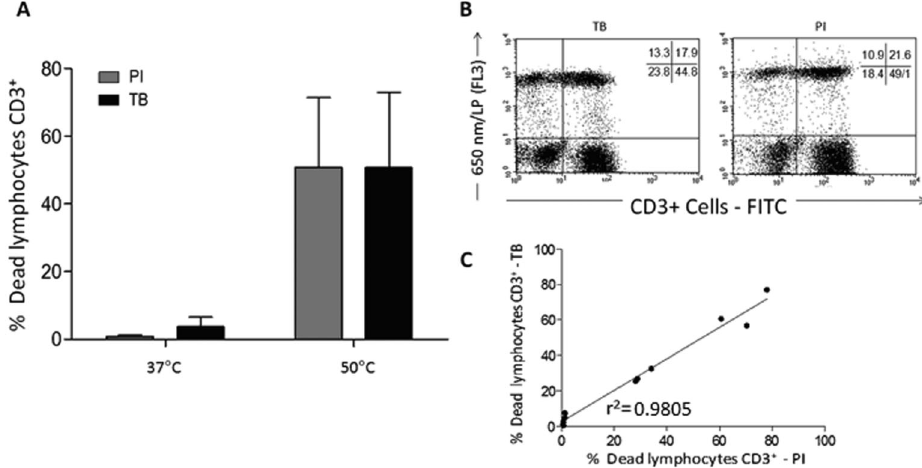
Figure 7. A , Percentage of dead human T-lymphocytes (CD3-FITC + cells) submitted to cell culture at temperatures (T) of 37 6 C (physiologic temperature) or 50 6 C (high-stress temperature) followed by staining with trypan blue (TB) or propidium iodide (PI). B , Dot- plot graph profile between human lymphocytes submitted to pretreatment with high-stress temperature (50 6 C) followed by staining with TB and PI and monoclonal antibody anti-CD3-FITC + . C , Pearson’s correlation test between dead CD3 + lymphocytes using PI and TB flow cytometry